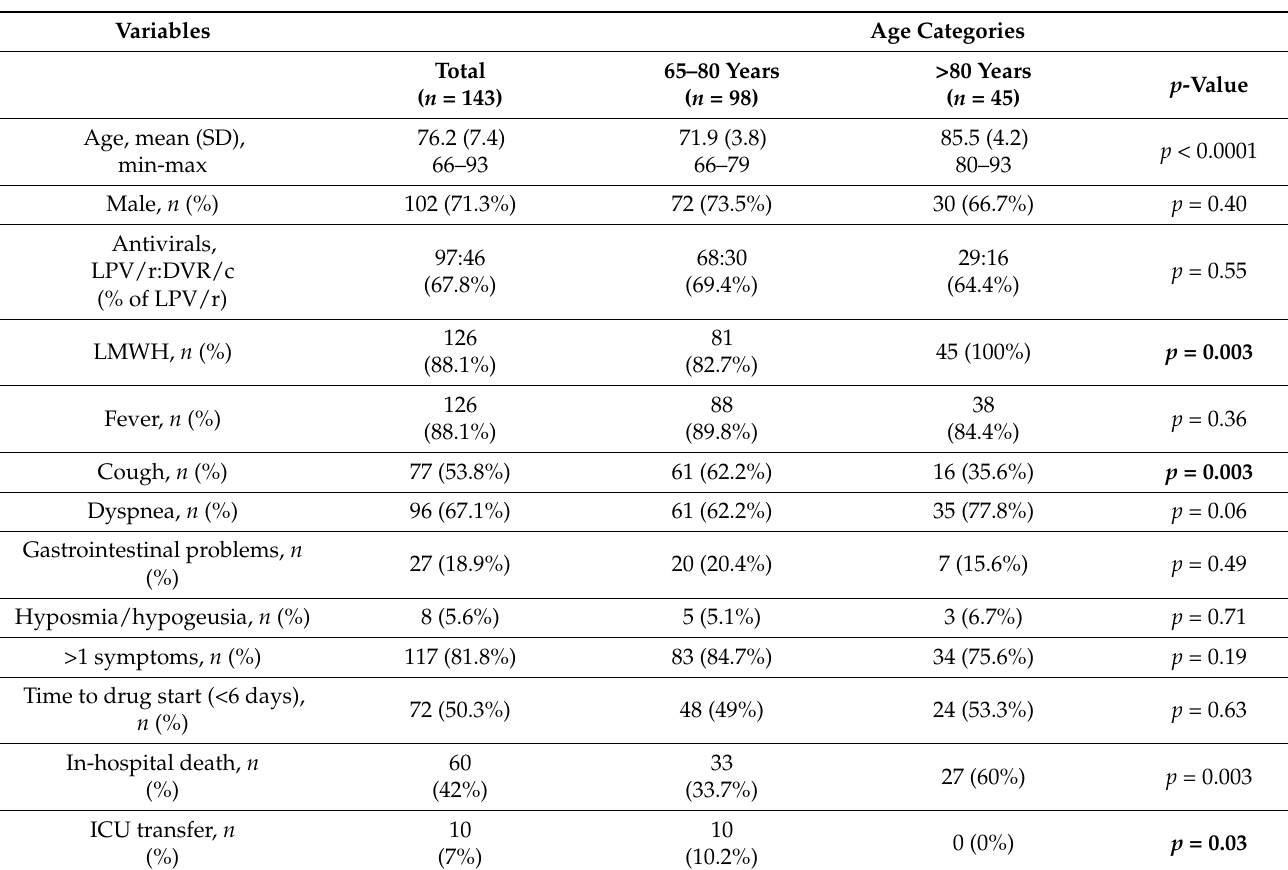
Table 1. Baseline clinical features of patients stratified by age category (65–80 years and >80 years). The p value refers to the comparison between >80 years to 65–80